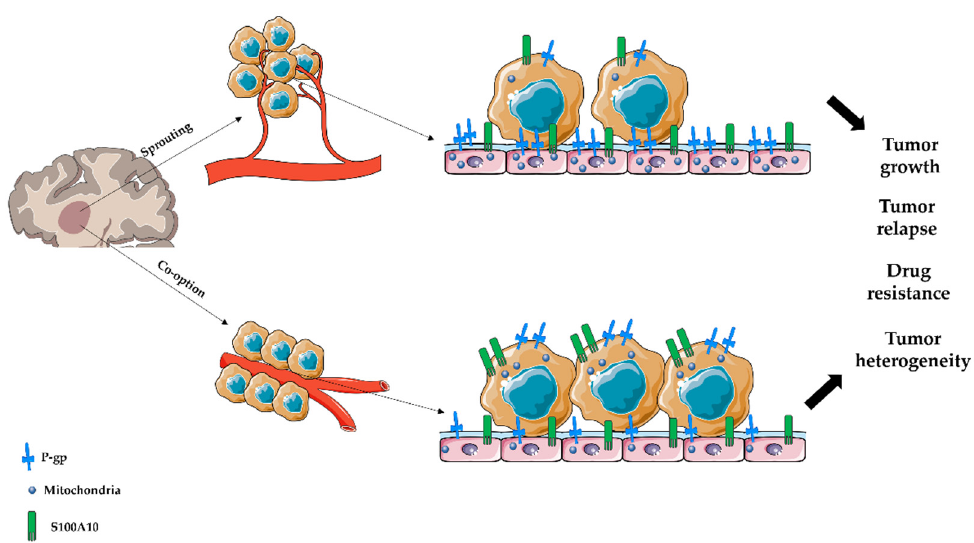
Figure 1. P-gp, S100A10, and mitochondria expression by tumor cells or ECs during sprouting angiogenesis or vascular co-option. Based on our observation and the literature, we postulated that where sprouting angiogenesis occurs: tumor cells can be identified as P-gp + or S100A10 + cells with a moderate proliferating profile (evaluated as mitochondria positivity); ECs overexpress P-gp and mitochondria compared with tumor cells and with ECs in the area where vascular co-option occurs. Moreover, we postulated that where vascular co-option occurs: tumor cells overexpress P-gp, mitochondria, and S100A10 compared with ECs and with the tumor cells in the area where sprouting angiogenesis occurs; ECs express P-gp, mitochondria, and S100A10 but lesser than tumor cells or the ECs in the area where sprouting angiogenesis occurs. These different ways of tumor progression could mainly involve diverse mechanisms such as tumor growth, heterogeneity and relapse, and drug resistance.